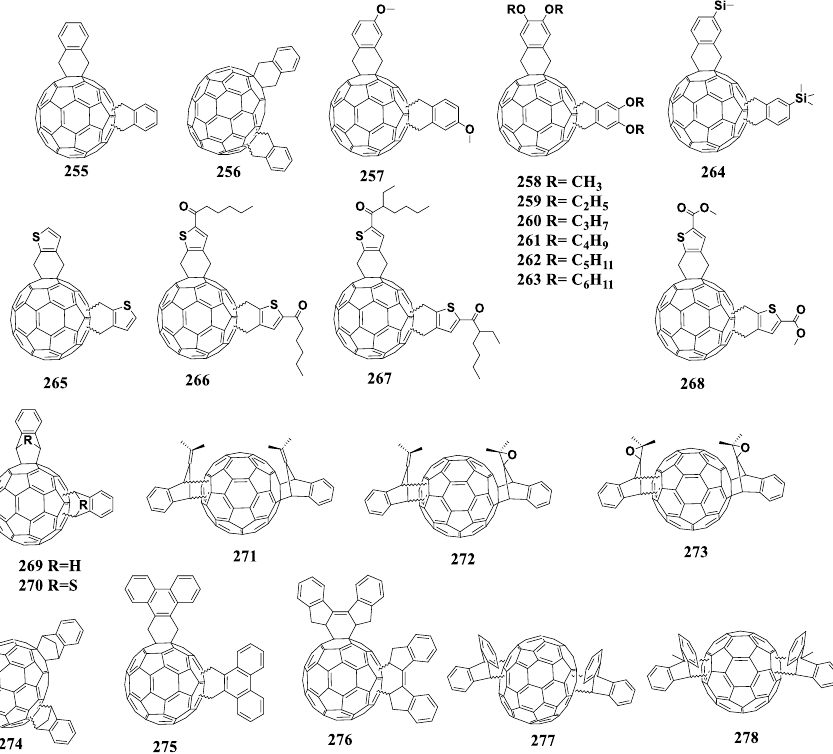
Figure 21. Molecular structures of the bis(cyclohexene) fullerene adducts with reduced electron affinity.